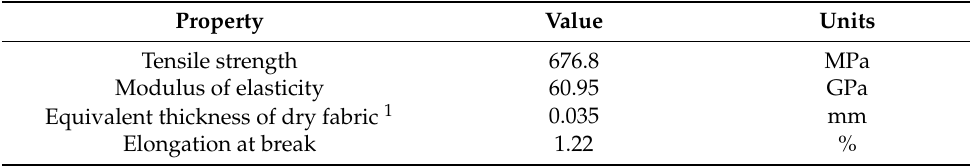
Table 2. The mechanical properties of the glass fiber mesh experimentally obtained in [24]. Property Value Units Tensile strength 676.8 Modulus of elasticity 60.95 Equivalent thickness of dry fabric 1